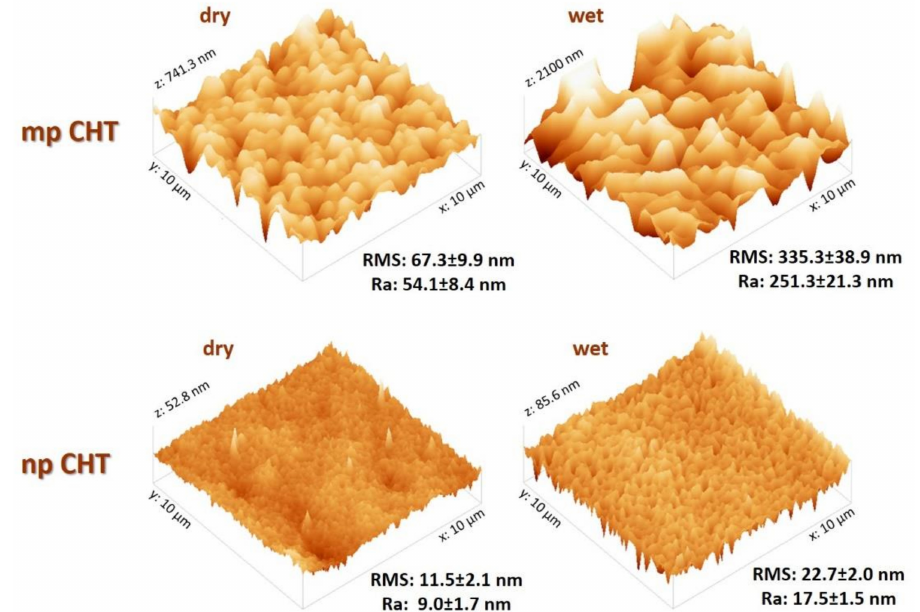
Figure 3. AFM images of 10 × 10 µ m microporous chitosan (mp CHT) and nanoporous chitosan (np CHT) membrane surfaces in dry and wet conditions, and relative roughness values in terms of Ra (average absolute distance from average flat surface) and RMS (root mean square from average flat